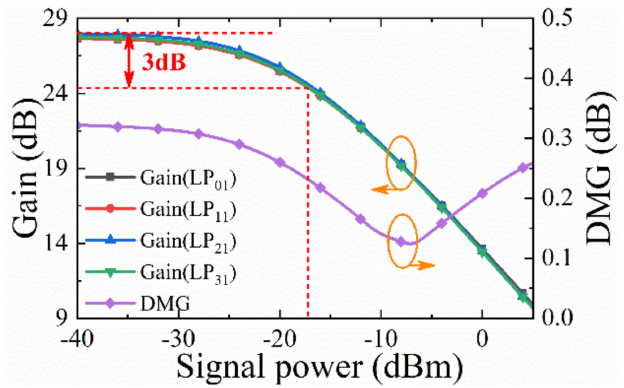
Figure 5. Gain saturation characteristic.